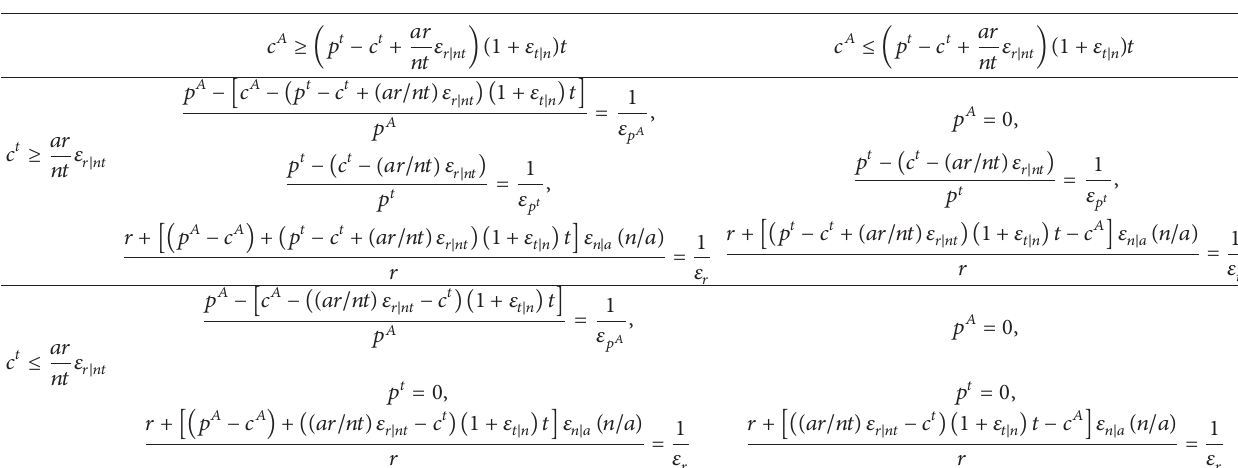
Table 1: The optimal price structure of monopolistic IM